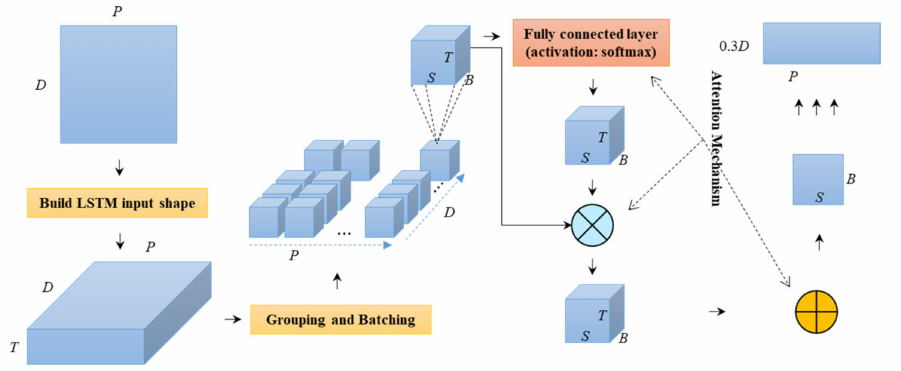
Figure 3. The structure of P-ATT model.